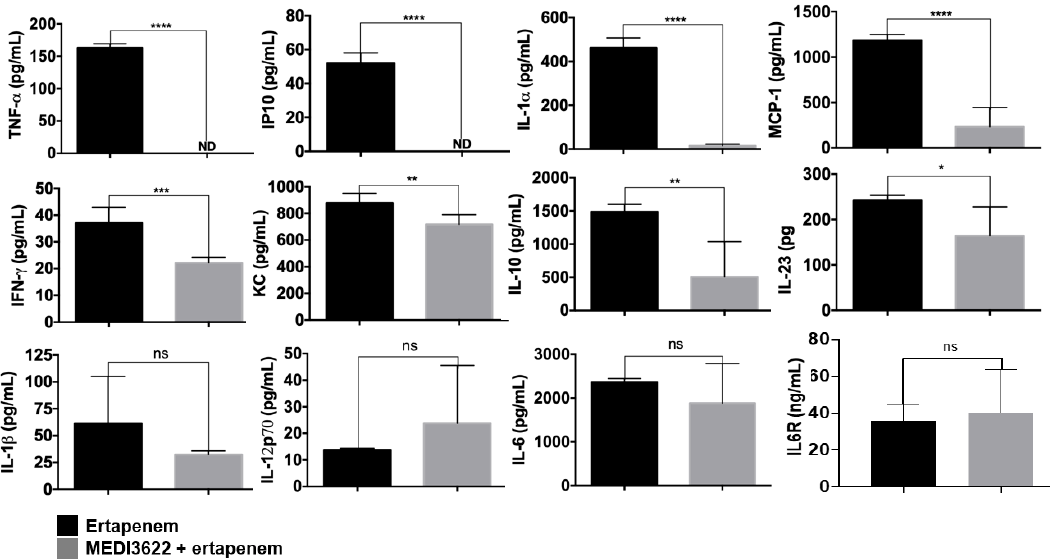
Figure 3. A combination of MEDI3622 and antibiotic treatment alters the plasma levels of various cytokines and chemokines. Mice were treated as described in Figure 2. Plasma levels of the indicated analytes were quantified 24 h post-CLP. N = at least 4 mice per group, ND = not detectable, data presented as mean ± SD, * p < 0.05, ** p <0.01, *** p <0.001, **** p <0.0001.